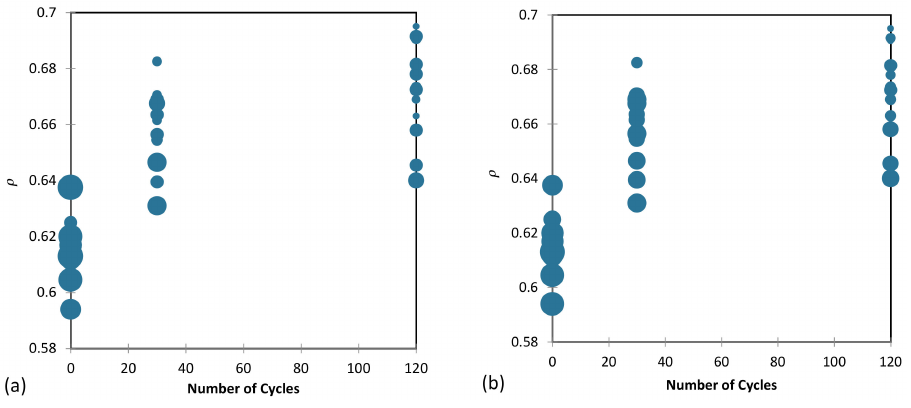
Figure 20. Effects of cycling loading on ( a ) e min and ( b ) e max based on the regularity ρ parameter.